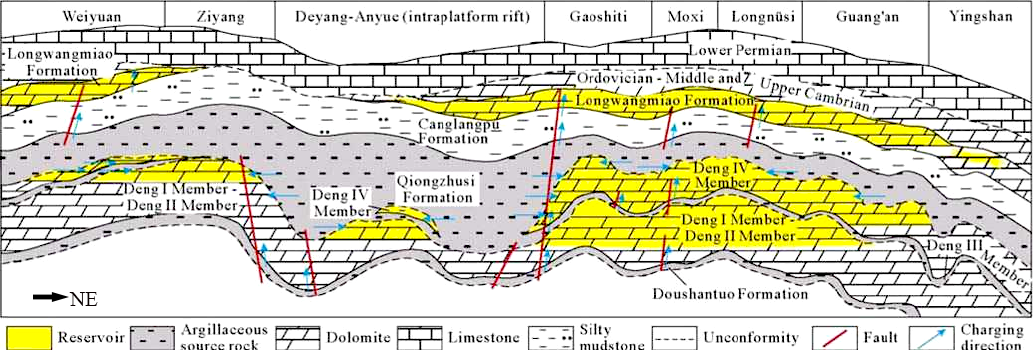
Figure 2. Schematic representation of the distribution of carbonate gas reservoirs in central Sichuan Basin [45].